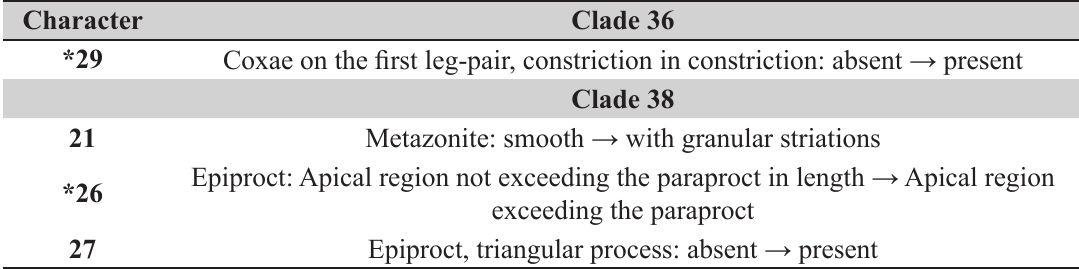
Table 6. List of characters recovered to support the clade 36 and 38 from the cladistic analysis (see Fig. 4). Only discrete characters are shown. Characters marked with an asterisk (*) are homoplastic